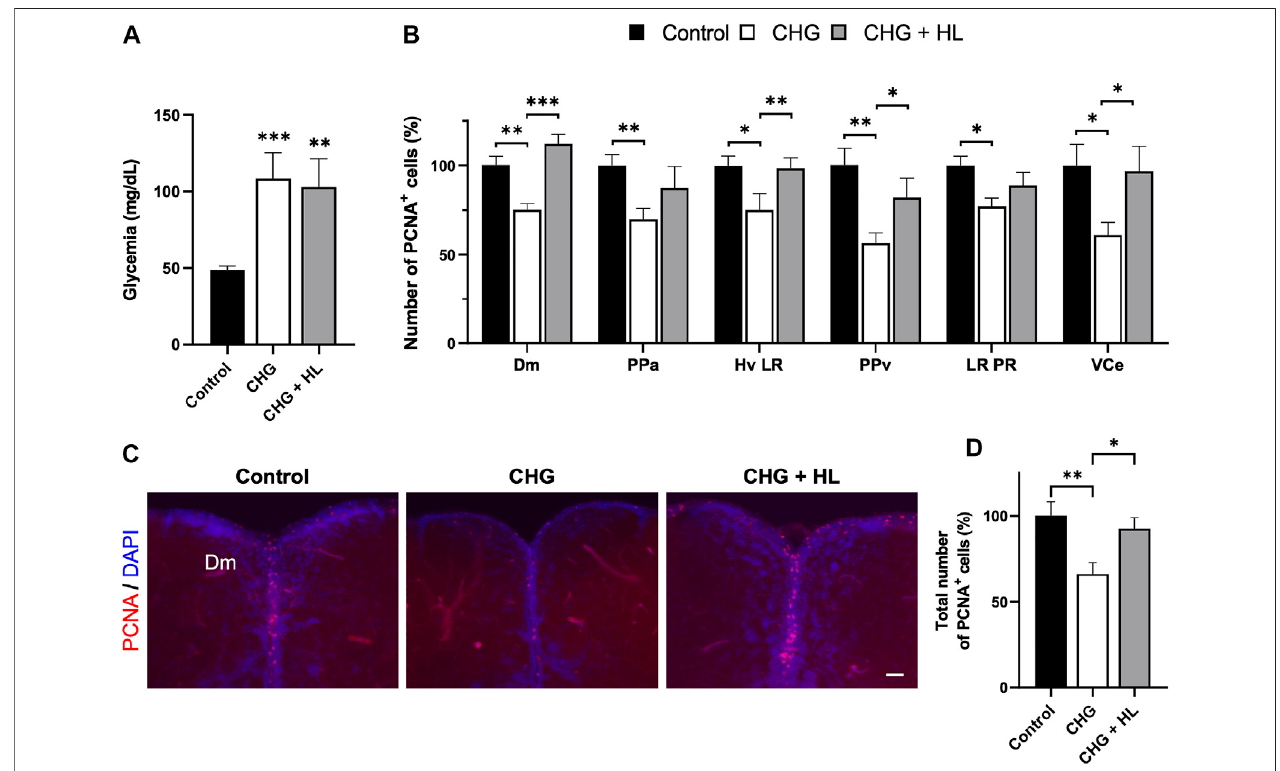
FIGURE 12 | H. lanceolatum aqueous extract has “ anti-diabetic ” effects by maintaining homeostatic neurogenesis in chronic hyperglycemic adult fi sh. (A) Fasting blood glucose levels of control (Control), chronic hyperglycemic (CHG) and chronic hyperglycemic fi sh treated with H. lanceolatum (CHG + HL). (B) Number of PCNA- positive cells according to the studied neurogenic regions. (C) Representative pictures of proliferative activity (PCNA) in zebra fi sh brains. (D) Total number of PCNA- positive cells, counted in all the studied regions, in Control, CHG and CHG + HL-treated fi sh. Dm, medial zone of dorsal telencephalic area. PPa, parvocellular preopticnucleus,anteriorpart.Hv,ventralzoneofperiventricularhypothalamus.LR,lateralrecessofdiencephalicventricle.PPv,periventricularpretectalnucleus,ventral part. PR,posterior recess ofdiencephalicventricle.VCe, valvulacerebelli.Results are expressed asmeans ±SEM (n=11 – 14/group). * p < 0.05, ** p < 0.01, *** p < 0.001 (One-way ANOVA). Bar = 40